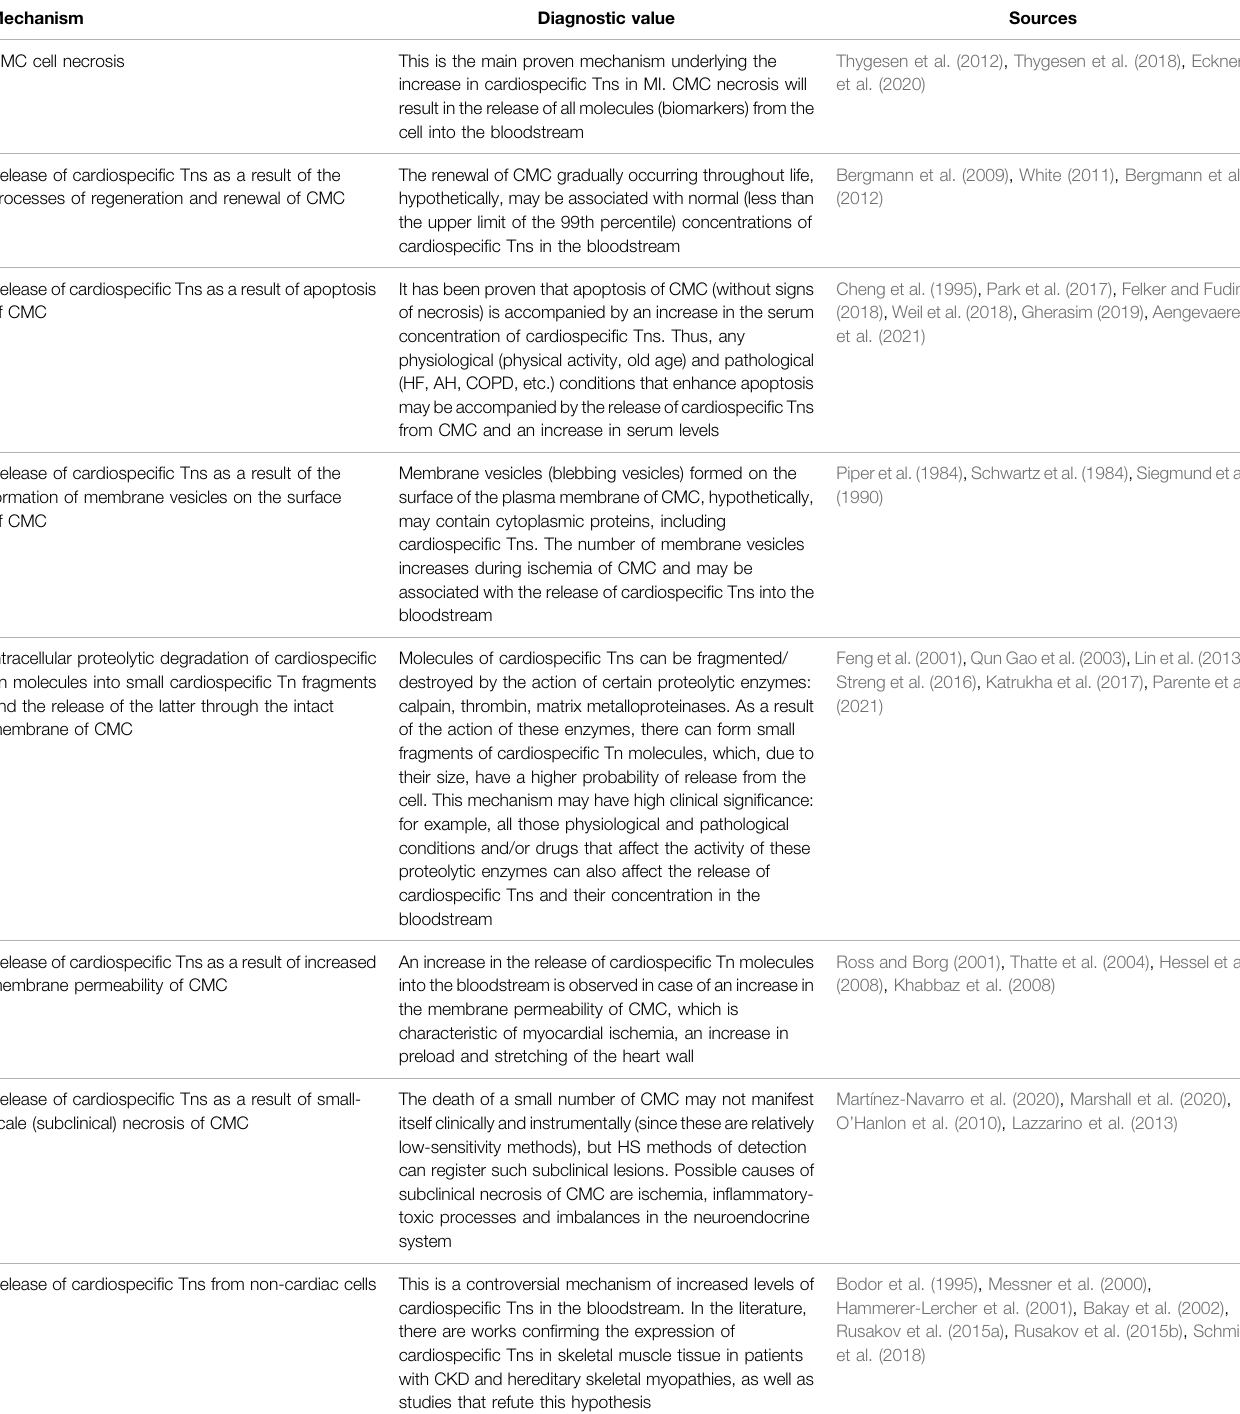
TABLE 3 | Release of cardiospeci fi c Tns from CMC: mechanisms and diagnostic role. Mechanism Diagnostic value Sources CMC cell